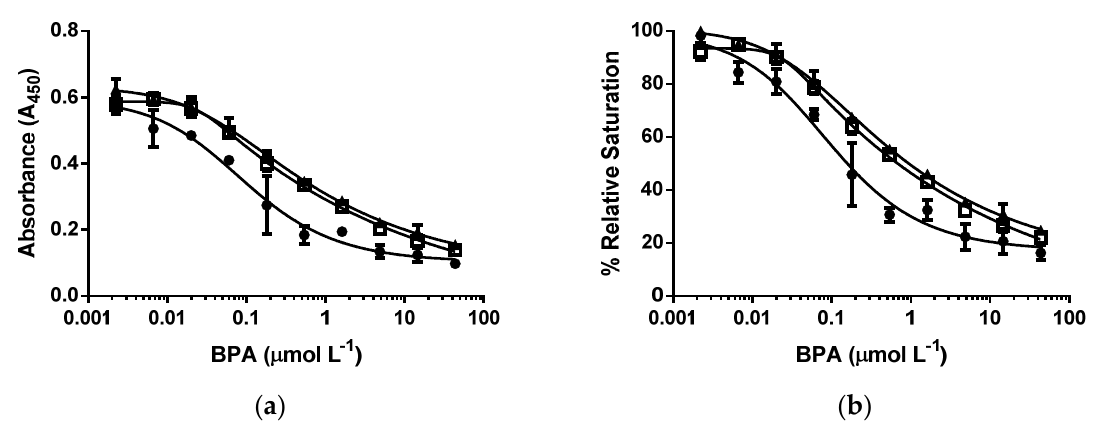
Figure 4. Dose–response curves of d-ELISA under the same molar concentration of cysBPAv-AuNP-190, cysBPAv-AuNP-396, and cysBPAv-AuNP-801. ( a ) Absorbance curve, and ( b ) % relative saturation. = the molar concentration of cysBPA-AuNP-190 was 2.1 × 10 − 10 mol·L − 1 (the molar concentration of epitope in an assay: 4.0 × 10 − 8 mol·L − 1 ); = the molar concentration of cysBPA-AuNP-396 was 2.1 × 10 − 10 mol·L − 1 (the molar concentration of epitope in an assay: 8.0 × 10 − 8 mol·L − 1 ); = the molar concentration of cysBPA-AuNP-801 was 2.1 × 10 − 10 mol·L − 1 (the molar concentration of epitope in an assay: 1.6 × 10 − 7 mol·L − 1 ).